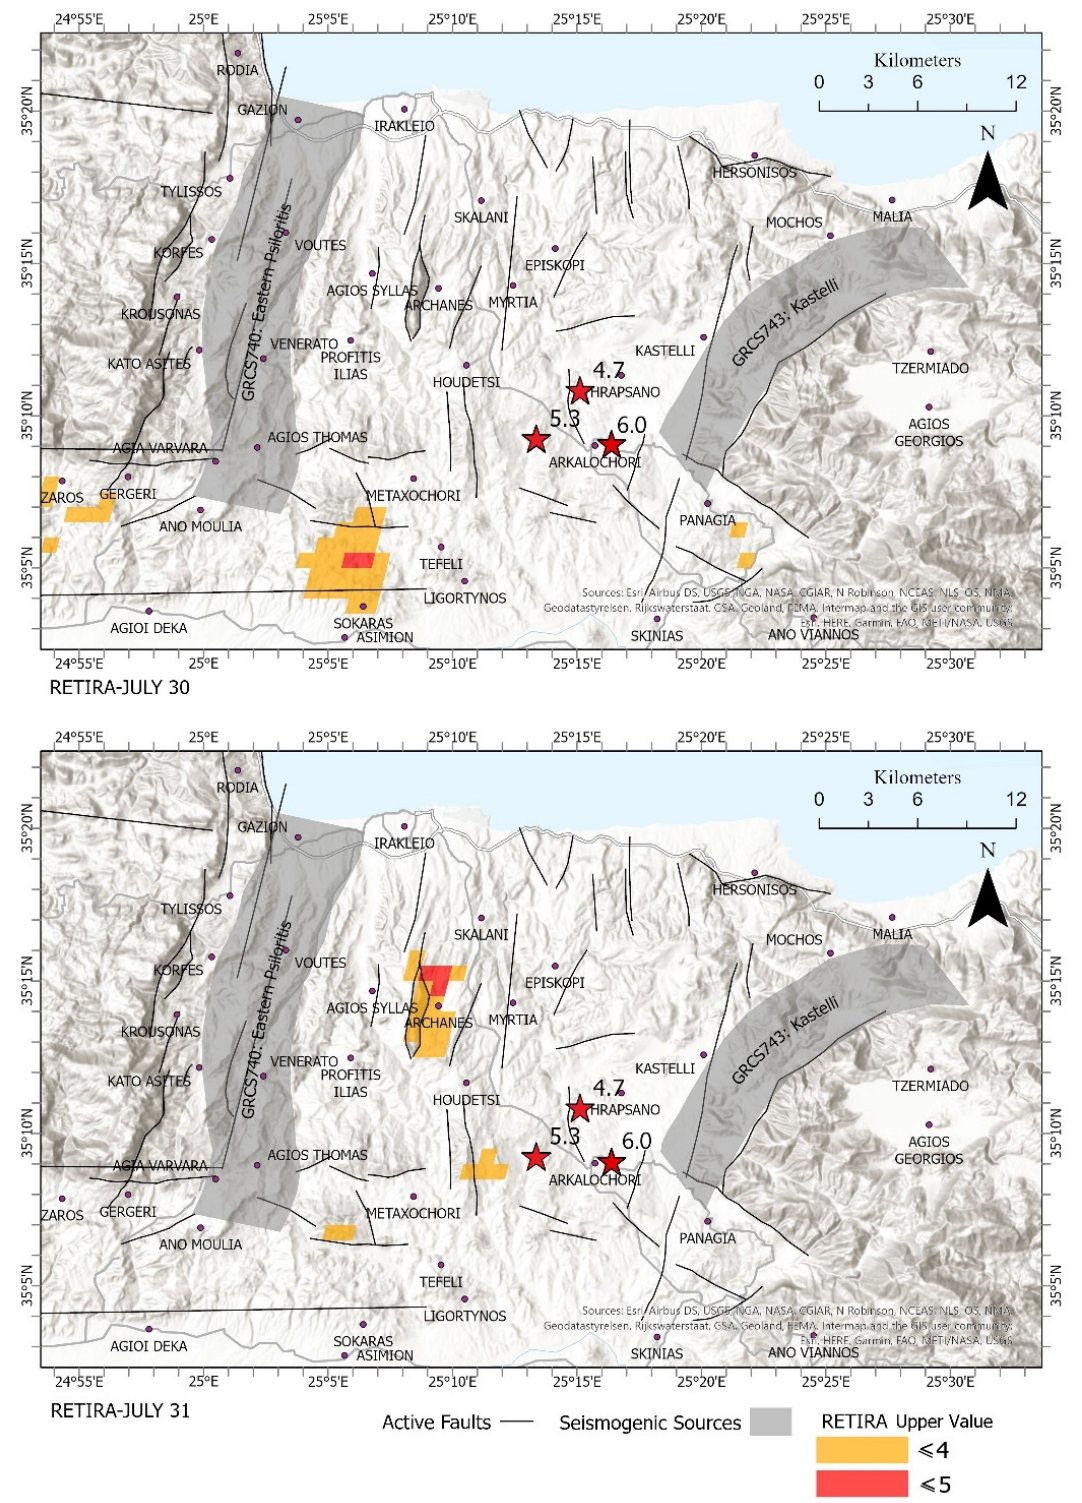
Figure 2. RETIRA thermal anomalies observed in the broader earthquake area of Central Crete during July 2021 are depicted with graduated colors depending on their value. The seismogenic source zones and the active faults are also indicated. The epicenters of the main event and of the two major aftershocks are shown with red